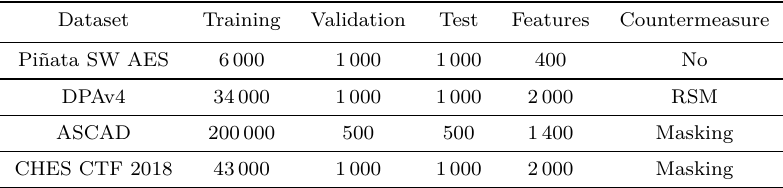
Table 1: Publicly available